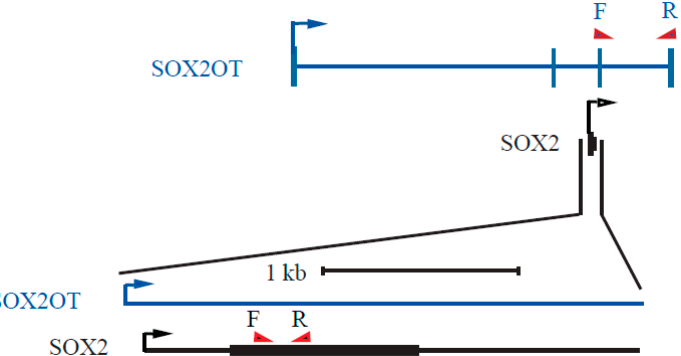
Figure 1. Schematic of the SOX2 and SOXOT genes. The SOX2 gene lies in an intronic region of the SOX2 Overlapping Transcript gene ( SOX2OT ). The direction of the transcription is shown with arrows. The triangles above each gene show the forward ( F ) and reverse ( R ) primers used in PCR. The SOX2 gene is enlarged.